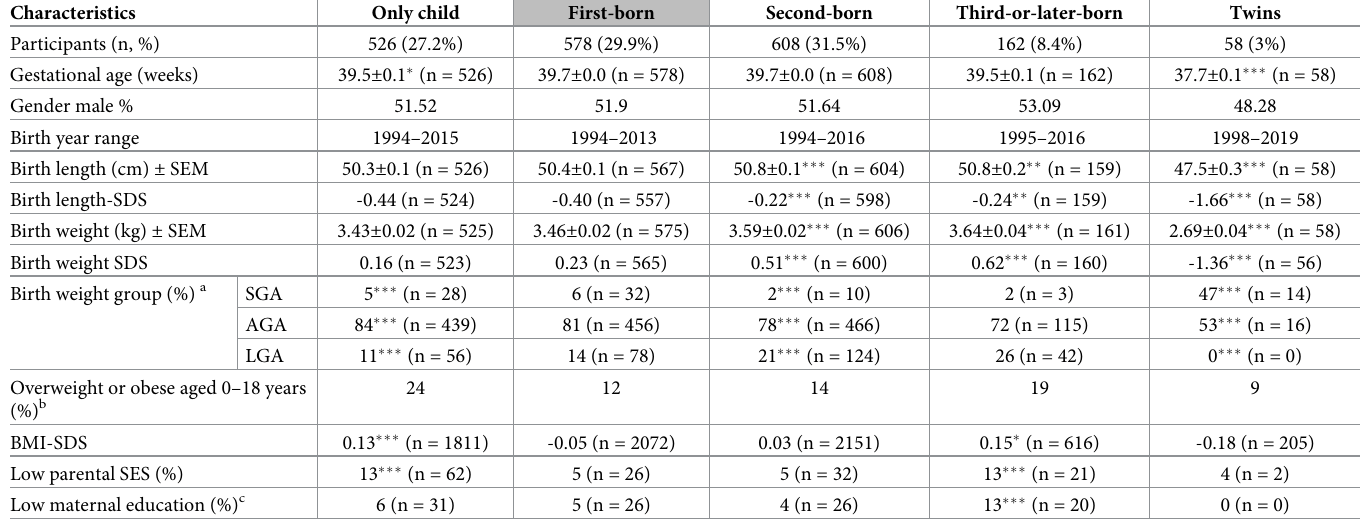
Table 1. Sample characteristics by sibling